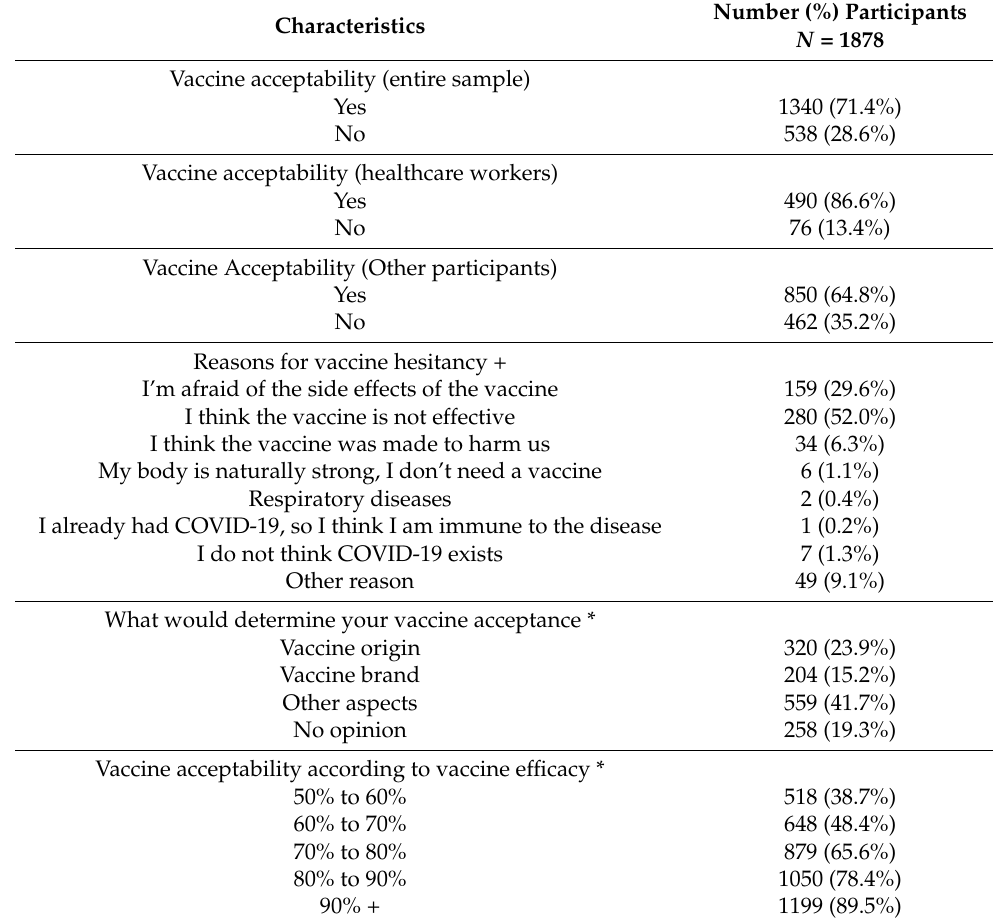
Table 3. Acceptability of the vaccine against COVID-19.